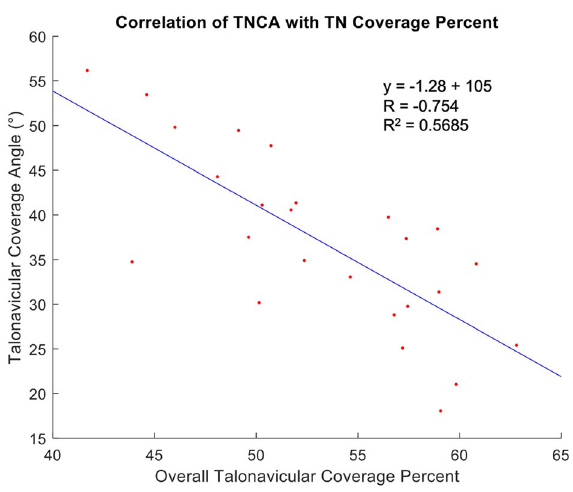
Figure 5. Correlation between the talonavicular three-dimensional (3D) coverage and the talonavicular coverage angle (TNCA). A moderate negative correlation was